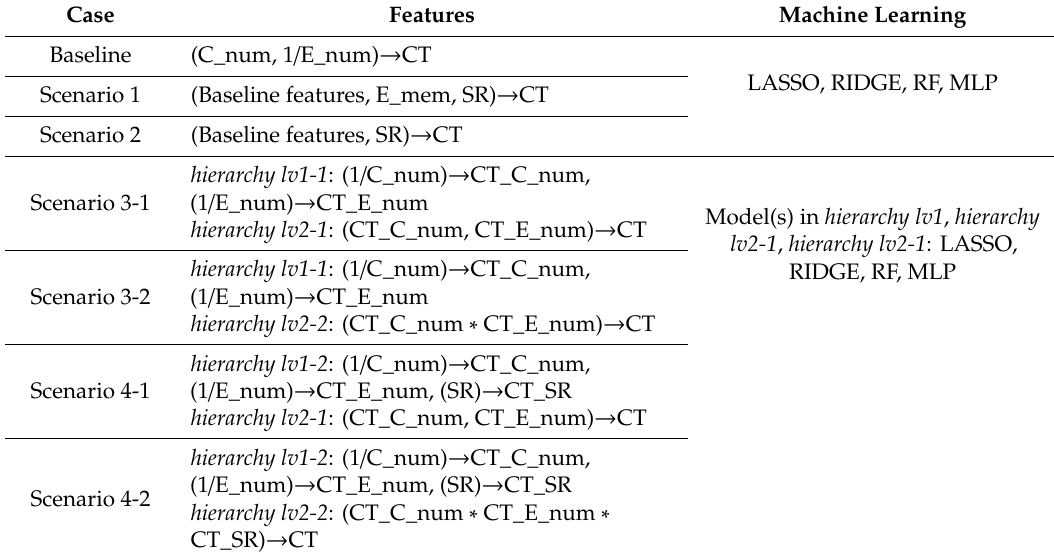
Table 8. Performance Model Verification Scenarios, Usage Parameters, and Machine Learning Techniques by